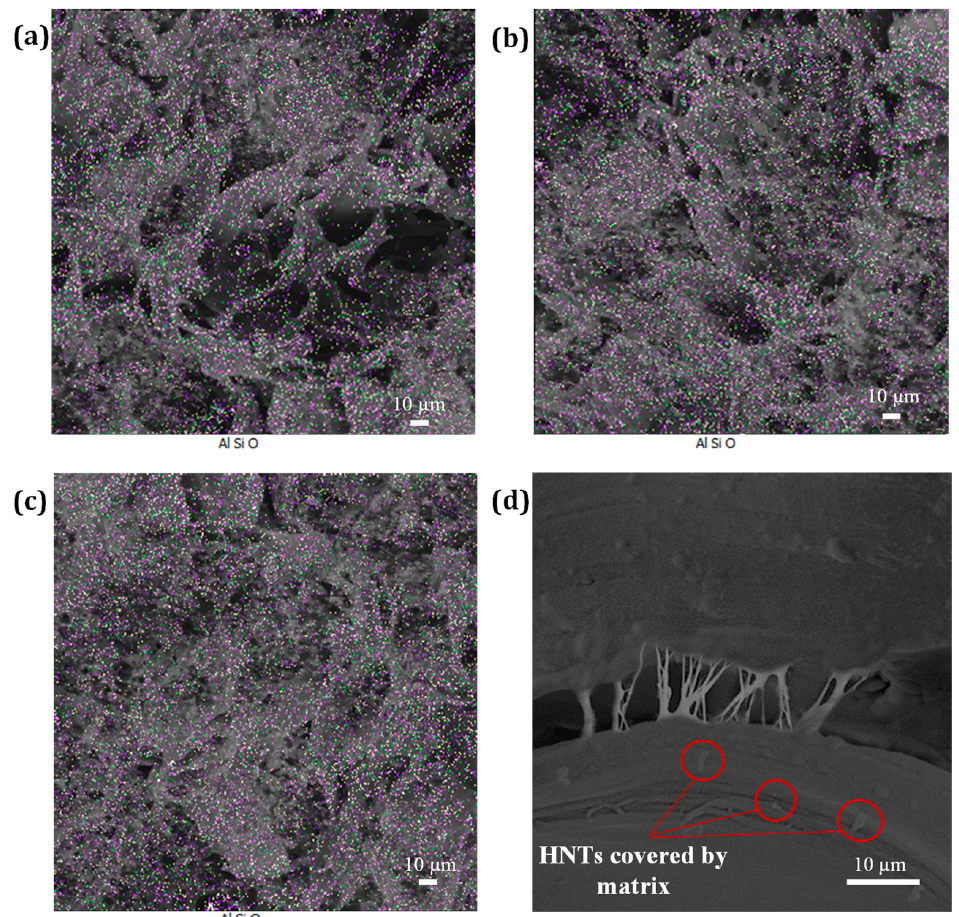
Figure 8. SEM-EDAX micrographs of FS-welded PP/NBR/HNT nanocomposite samples with Figure 8. SEM ‐ EDAX micrographs of FS ‐ welded PP/NBR/HNT nanocomposite samples with ( a ) 3 ( a ) 3 wt.%, ( b ) 5 wt.%, and ( c , d ) 7 wt.% wt.%, ( b ) 5 wt.%, and ( c , d ) 7 wt.% HNTs.